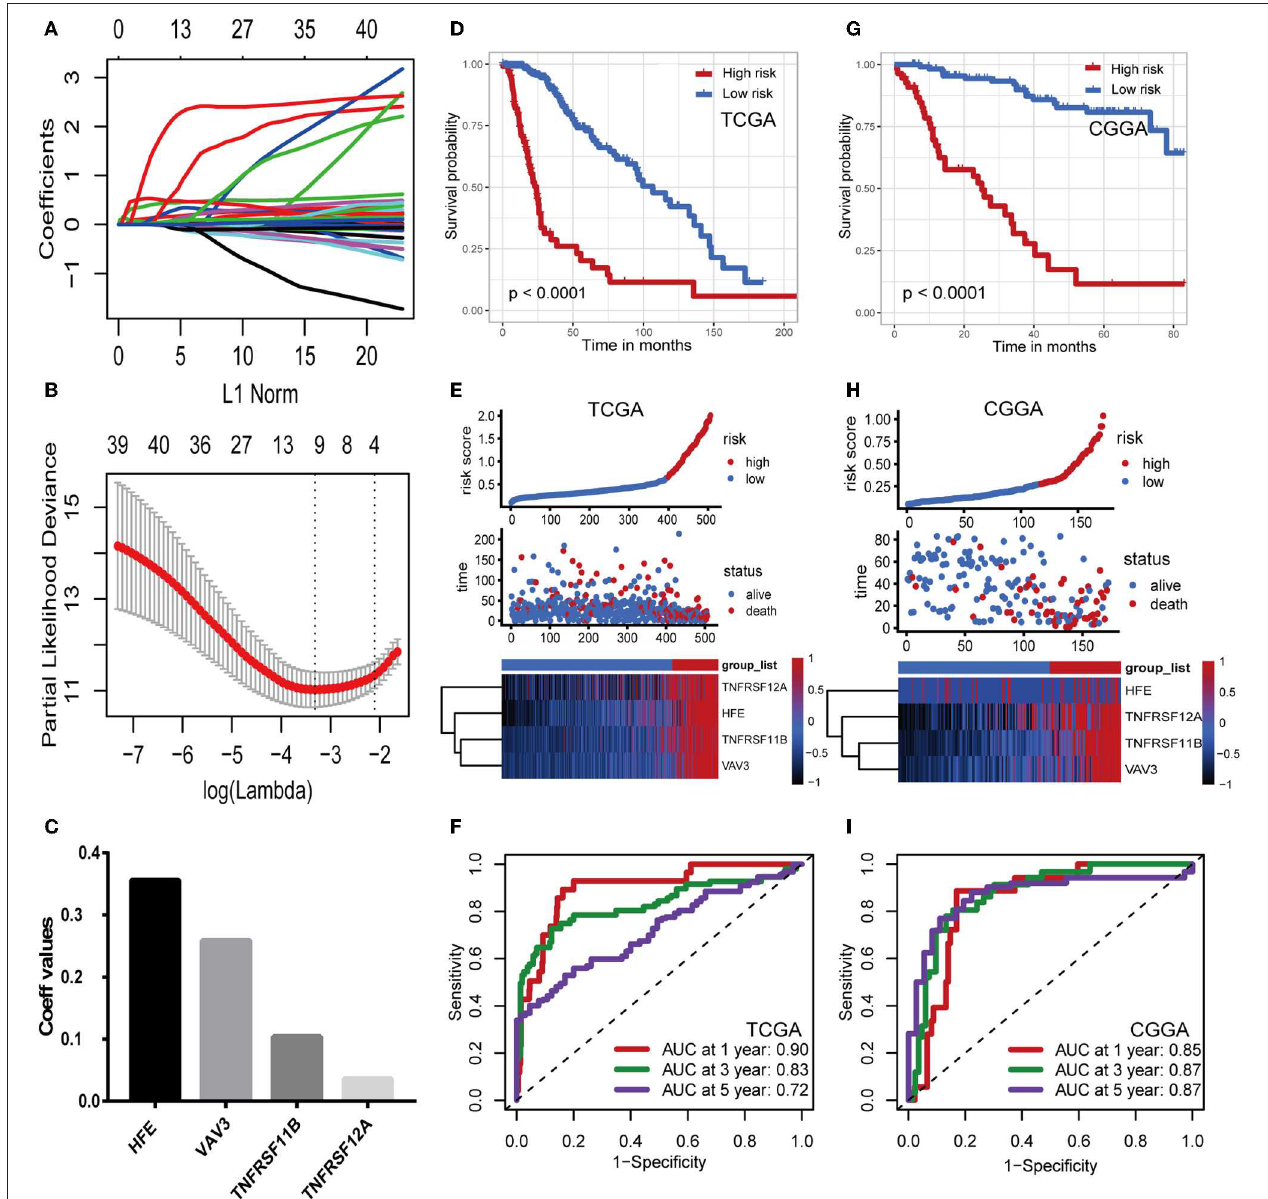
FIGURE 3 | Construction and validation of the immune prognostic signature. (A,B) LASSO Cox analysis identified four genes most correlated to overall survival in TCGA set. (C) Coefficient values for each of the four selected genes. (D,G) Kaplan–Meier curves of overall survival for LGG patients based on the IPS in TCGA cohort and CGGA cohort. (E,H) Risk scores distribution, survival status of each patient, and heatmaps of prognostic four-gene signature in TCGA and CGGA cohorts. (F,I) Time-dependent ROC curve analysis of the IPS.